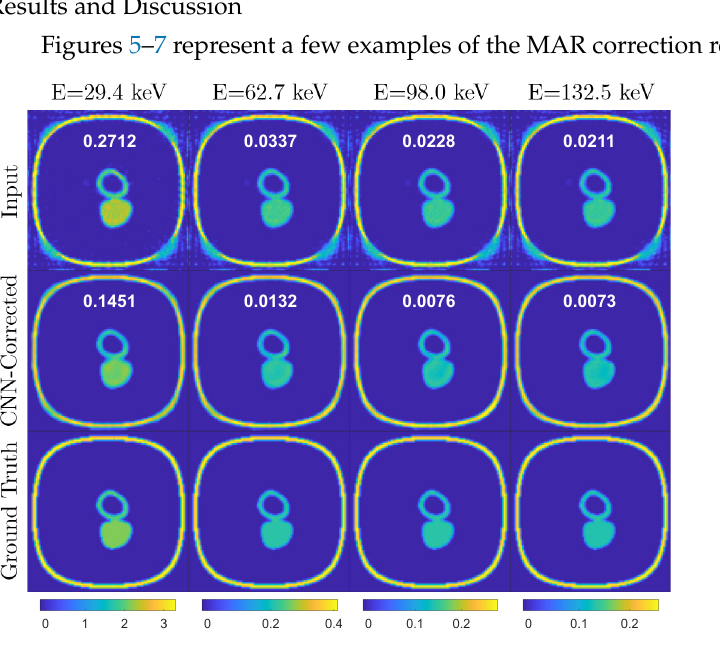
Figure 5. Simulation test data. Example 1: slice of the reconstructed volume at different energy channels when metal artifact affected (first row), MAR corrected (second row) and ground truth (third row). Each column corresponds to a fixed energy channel and they were plotted using the same color map. The color bar represents the LAC values. The inset number in the graphs reflects the RMSE value.